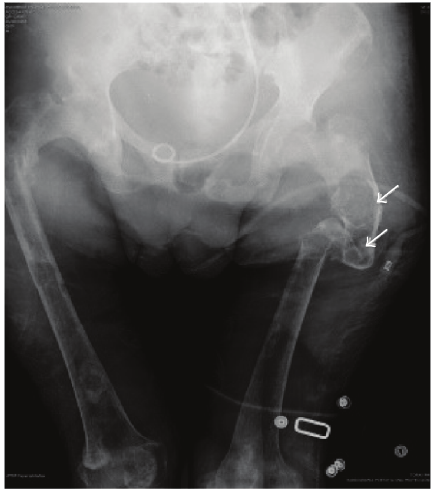
Figure 2: Pelvis X-ray with diffuse demineralization, marked decreaseincorticallongbone,cysts,andbrowntumors(arrows)and multiple pathological fractures for severe osteitis fibrous cystic.